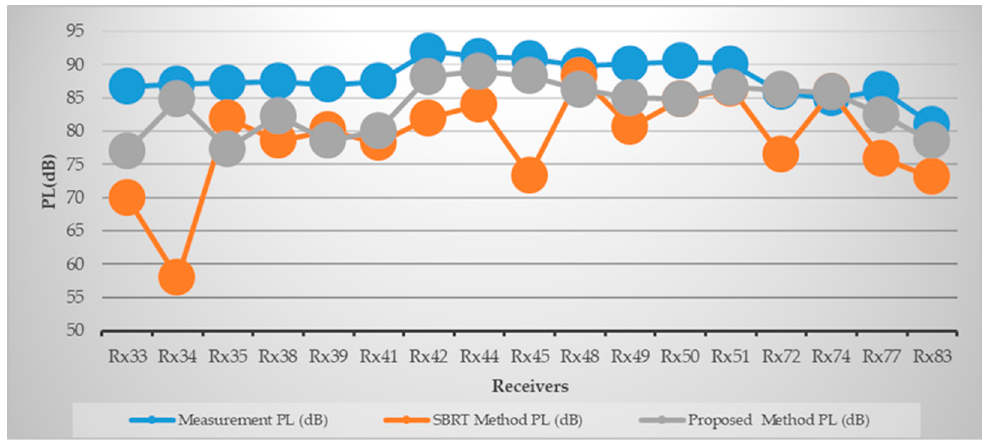
Figure 11. The PL comparison of line graphs among the measurement, SBRT method, and proposed method.